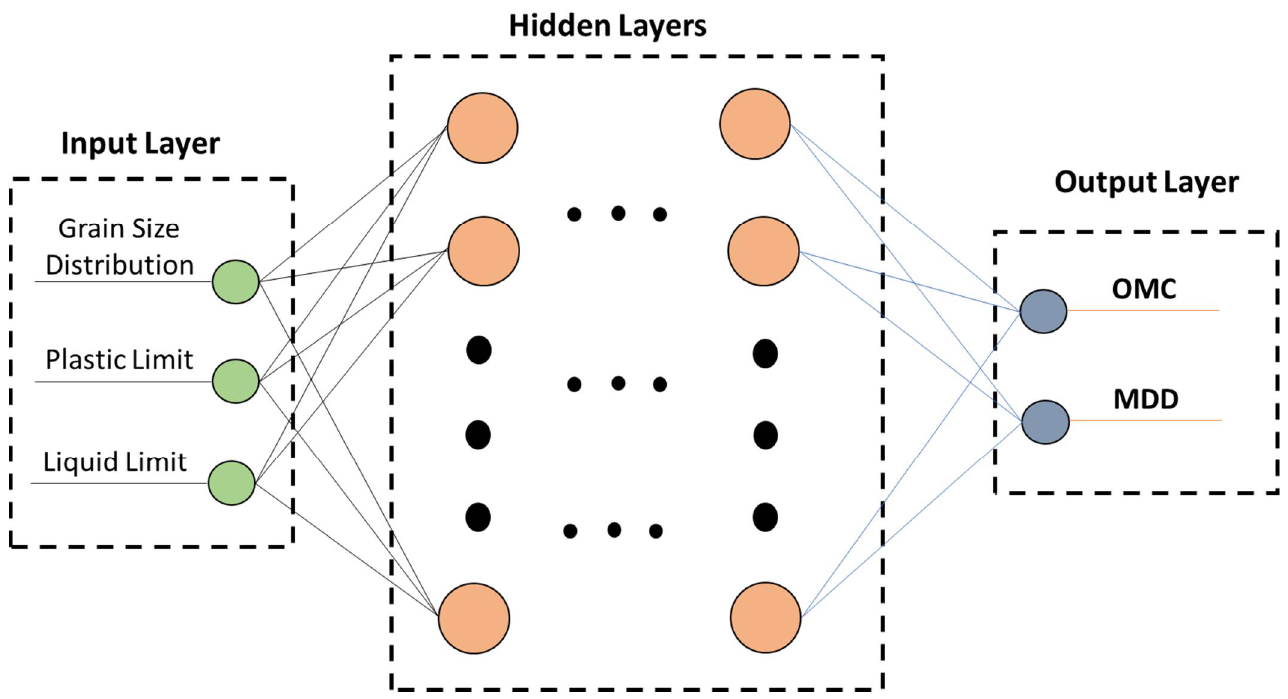
Figure 3. The general ANN structure followed